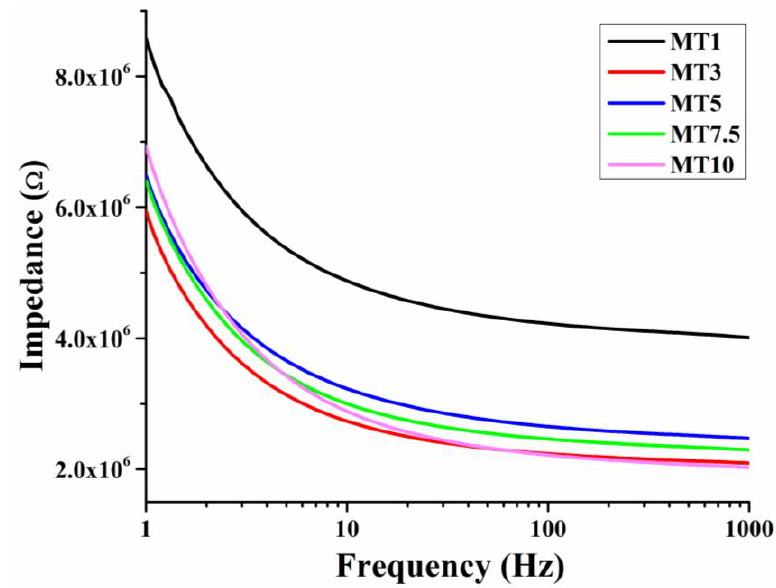
Figure 11. Impedance spectroscopy profile of WWF